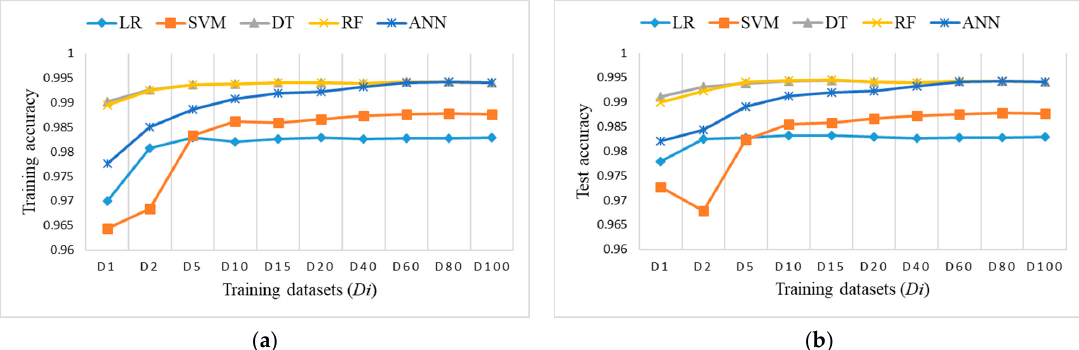
Figure 9. Accuracy measure on imbalanced training datasets Di : ( a ) training accuracy (coincidence of RF and DT); ( b ) test accuracy (coincidence of RF and DT).